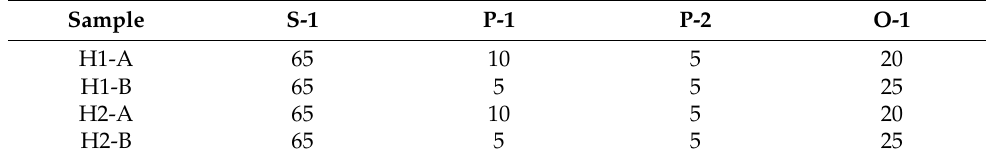
Table 2. Proportions of constituent raw materials in the charging mixes,